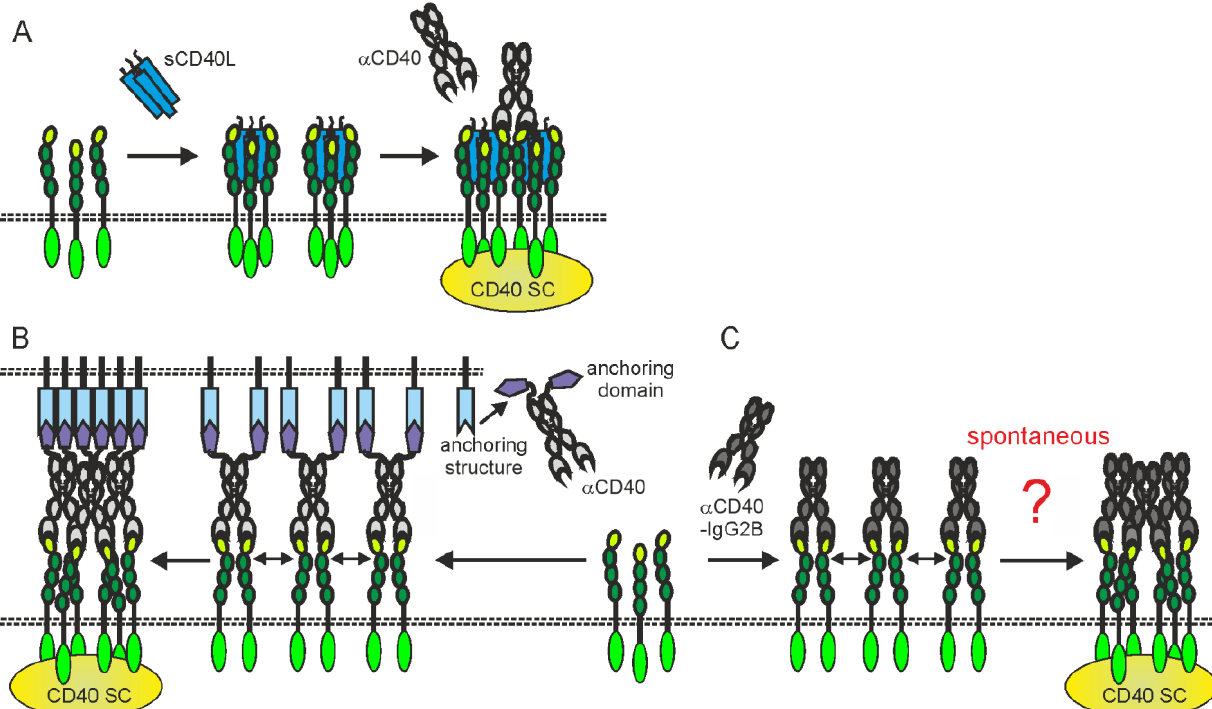
Figure 4. Activating CD40 clustering by ( A ) mixtures of sCD40L and non-blocking anti-CD40 antibodies, ( B ) anti-CD40 antibody fusion proteins with an anchoring domain enabling binding to a plasma membrane-localized anchoring structure or ( C ) anti-CD40-hIgG2 antibodies. Dotted lines indicate plasma membranes. For details, please see